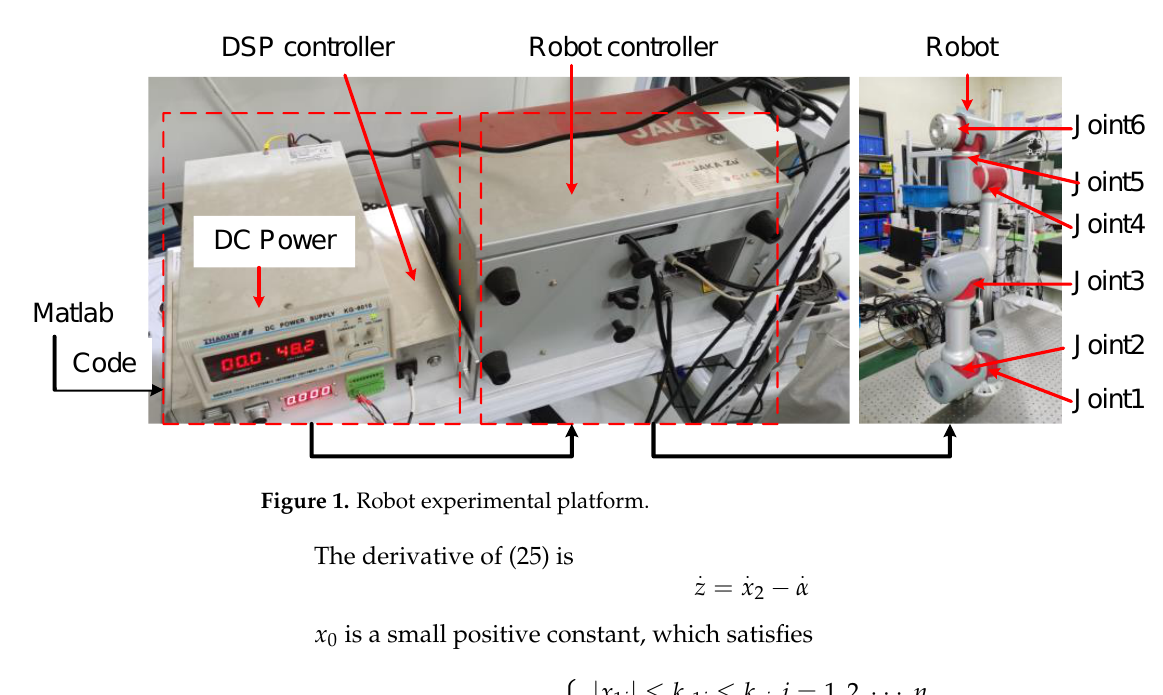
Figure 1. Robot experimental platform.